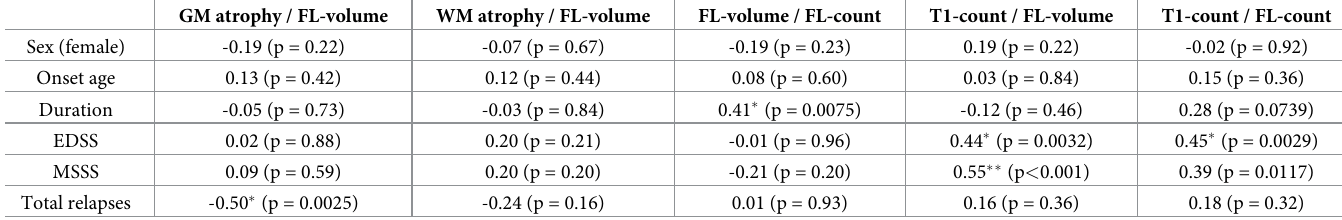
Table 2. Correlation matrix between volumetry-derived variables and disease severity.